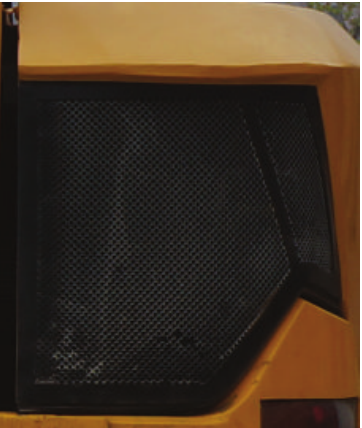
Figure 2: Actual inlet grids.